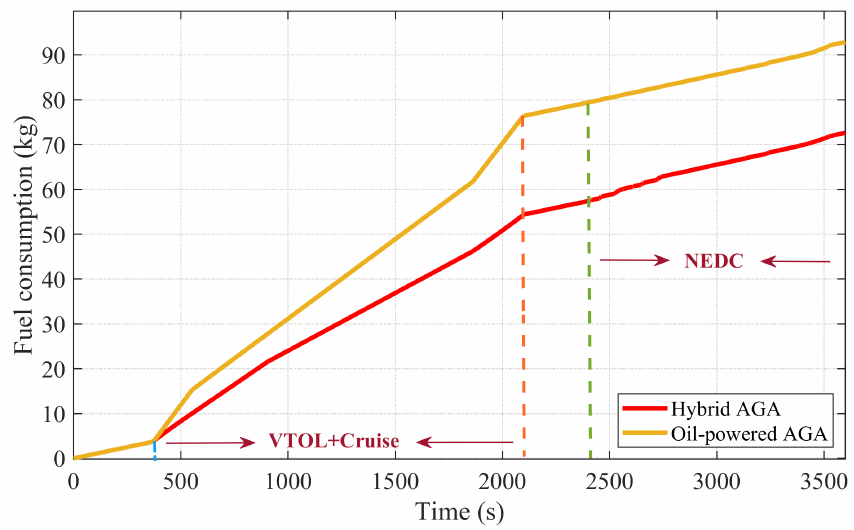
Figure 15. Fuel consumption comparison of the hybrid and oil-powered AGA under the air–ground amphibious mission.